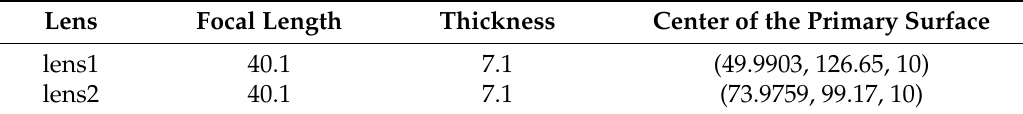
Table 4. Setup with lenses after BS2. All units in